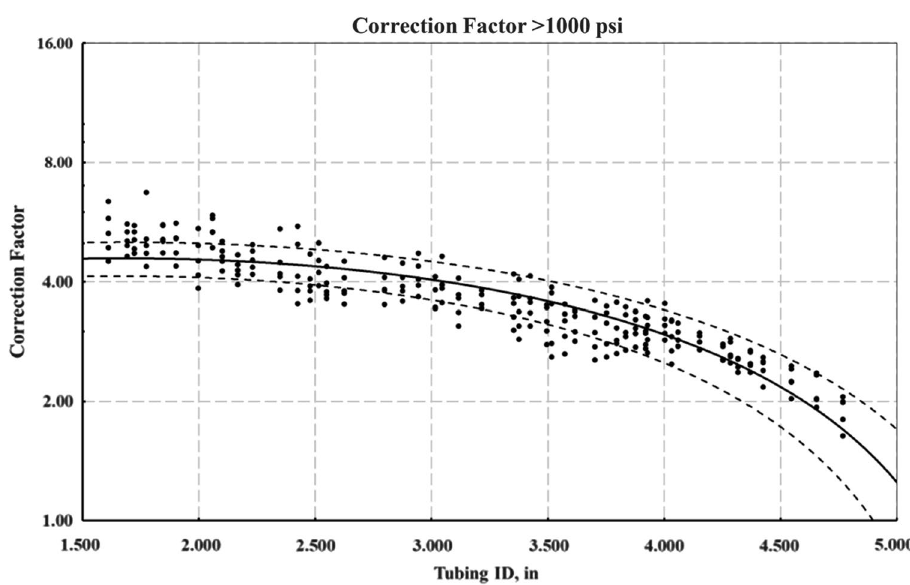
Fig. 6 Correction factor